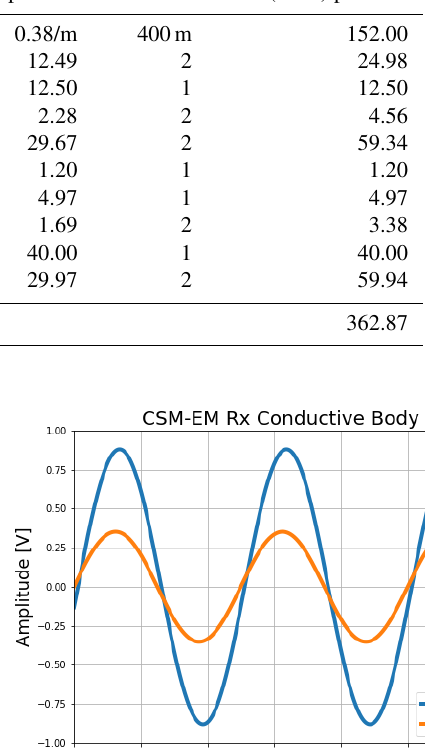
Table 1. Cost breakdown (in USD) for parts required to construct and operate the system. Note that this estimate assumes all products are bought new. Many components (especially wire) can be repurposed, allowing the system to be built at a lower overall cost. Item